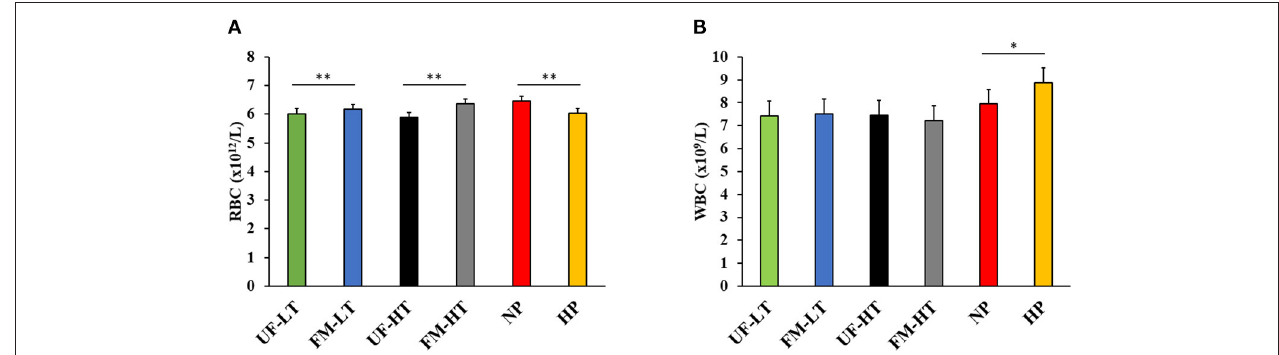
FIGURE 2 | Red [RBC; (A) ] and white [WBC; (B) ] blood cell counts in dogs fed either low (LT) or high (HT) tannin fava bean–based diets without (UF) or with (FM) fermentation, or normal vs. high protein commercial diets. Eight mixed-gender, neutered beagles were fed the NP, or HP diets during the first and sixth weeks, respectively. From weeks 2 to 5, using a randomized, crossover, 2 × 2 Latin square design, 4 diets differing in fava bean variety and fermentation were compared as follows: UF-HT, FM-HT, UF-LT, and FM-LT * P < 0.10; ** P < 0.05.